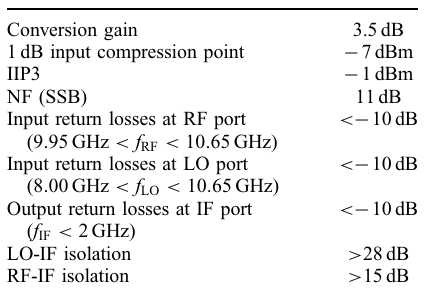
TABLE III Down-converter’s